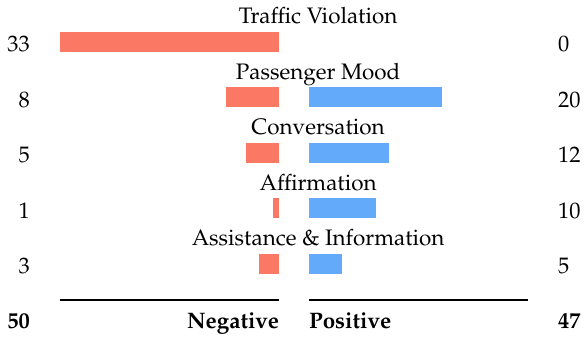
Figure 3. Positive mood and conversations inside the car are connected to positive emotions, as well as affirmation of the driver’s behavior. Traffic violations on the other hand are directly related to